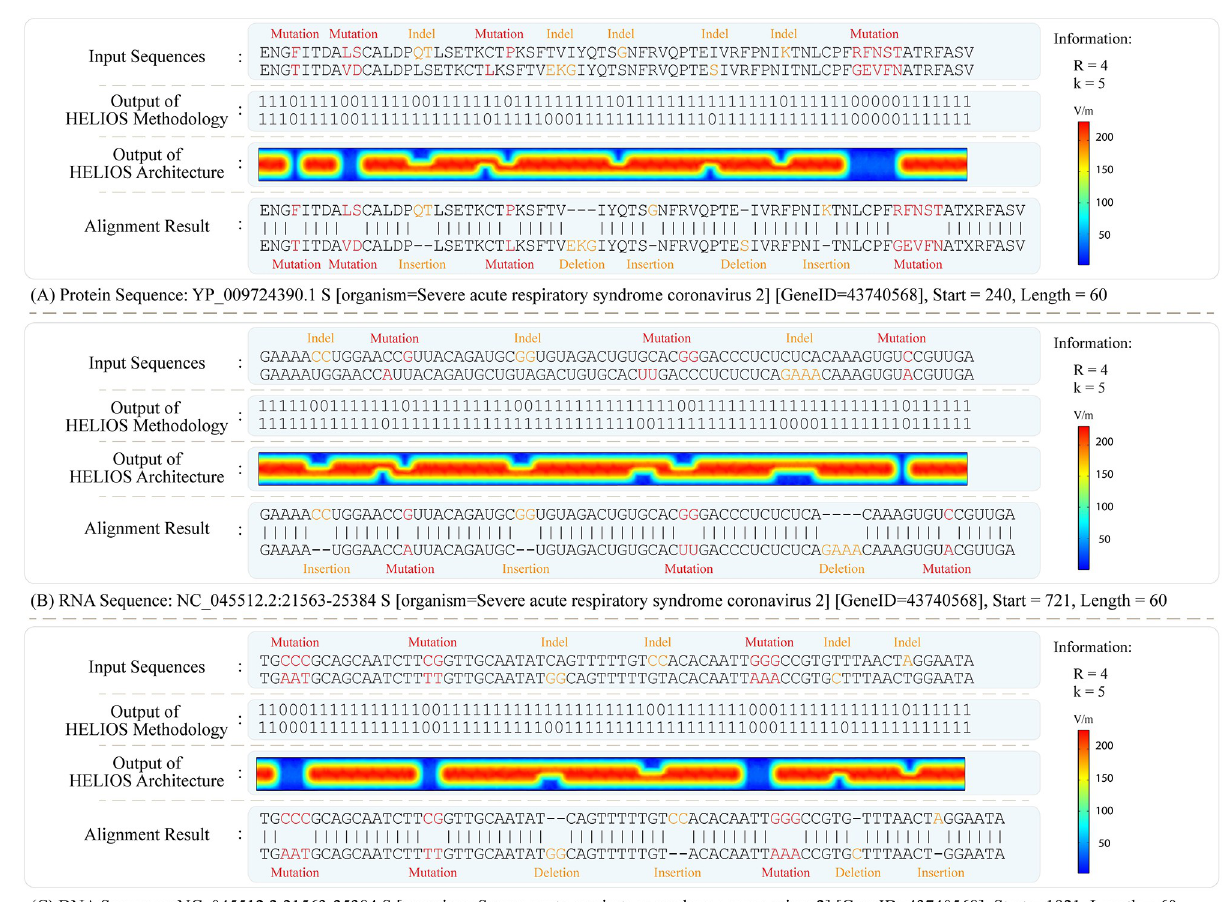
Fig 8. Simulation outputs of the HELIOS method and its optical architecture. In this case of study, the “Severe acute respiratory syndrome coronavirus 2” sequences [49] are aligned in the form of (A) Protein, (B) RNA, and (C) DNA; while some single and multiple mutations/indels are manually imposed to the sequence with varying distributions. For more clarity, only a small portion of each full-length alignment including 60 characters is shown in this figure, with the beginning at (A) character 240, (B) character 721, and (C) character 1921. In the coding and the alignment procedure, the parameters are set to R = 4 and k = 5. By investigating the outputs, two input sequences are successfully aligned in a two-line output by performing two consecutive procedures of the HELIOS method, as well as, passing optical beams through two units of the HELIOS optical architecture. As a result, the matches, mutations, and indels are detected and located